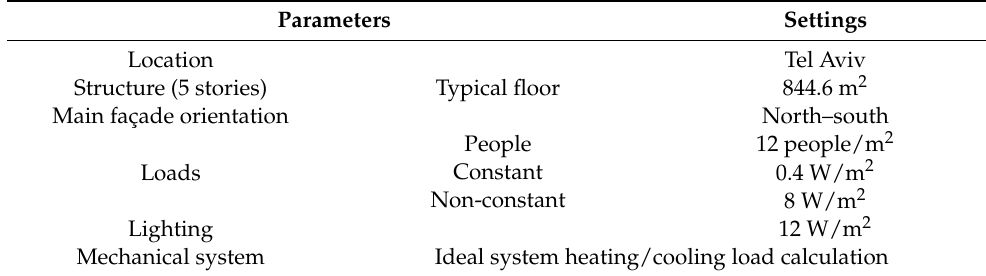
Table 1. Main settings of the studied typical office